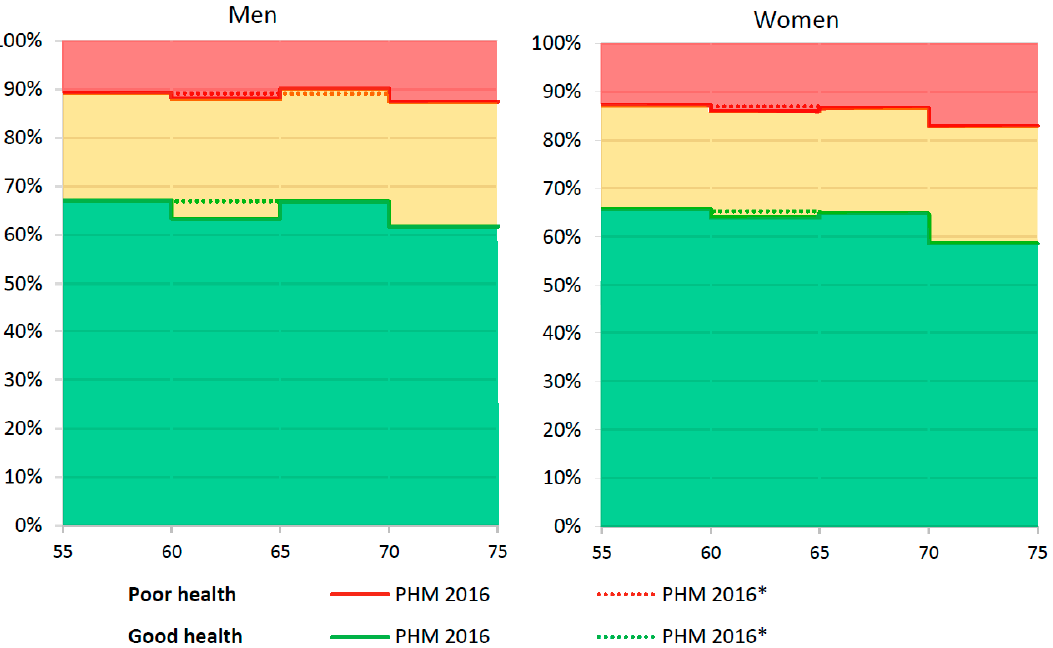
Figure 1. Health by age and gender in 2016, observed (denoted by PHM 2016) and reconstructed (denoted by PHM 2016*) Note. Prevalence of good health is below the green line and prevalence of poor health is above the red line, the intermediate area is prevalence of moderate health.